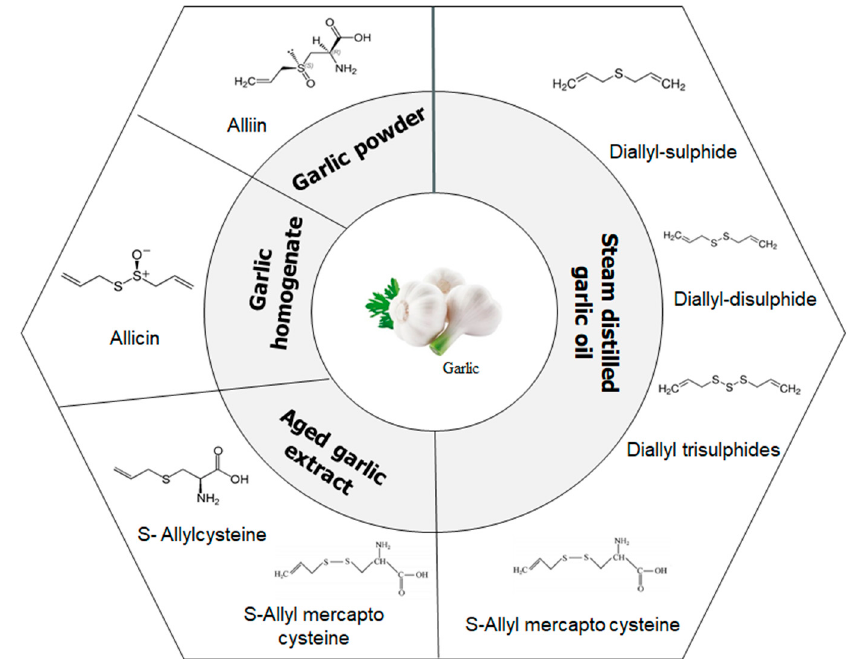
Figure 2. Schematic diagram of key water-soluble and oil-soluble sulphur compounds present in garlic ( A. sativum and types of available garlic products.